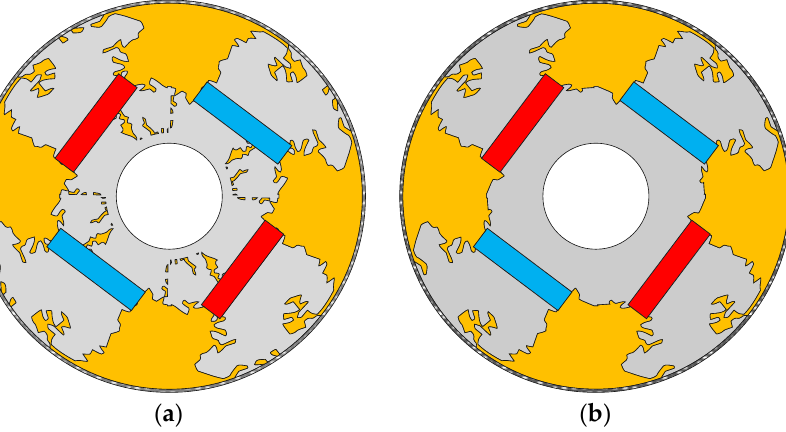
Figure 15. The whole model of the selected topology optimized AIPMSM rotors. The yellow parts are filled with resin epoxy, and a carbon fiber sleeve protects the whole rotor. ( a ) is the original model 0, the torque is 2.419 Nm, and the torque ripple is 0.308 Nm; ( b ) is the simplified model 0, the torque is 2.452 Nm, and the ripple is 0.366 Nm.